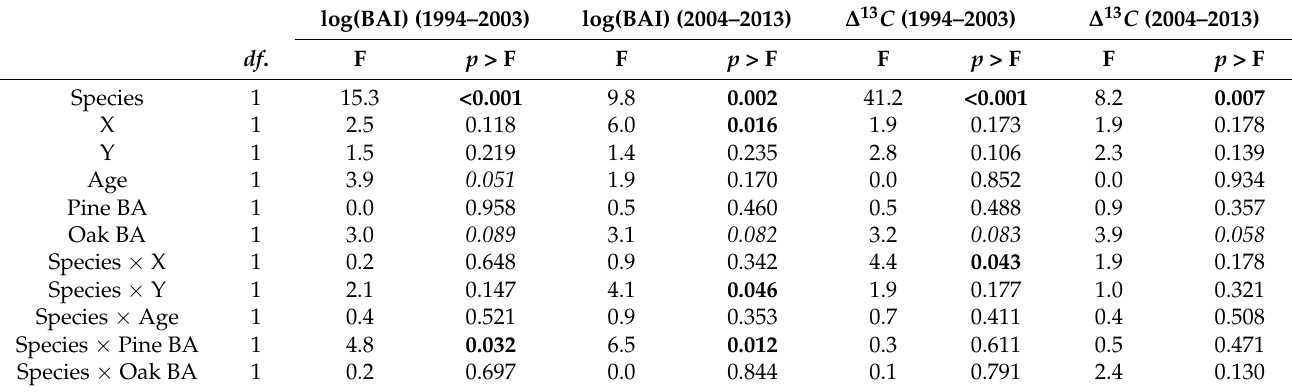
Table A3. Analyses of covariance (ANCOVAs, full models) for log-transformed individual basal area increment (log(BAI)) and carbon isotope discrimination ( ∆ 13 C ) during a wet (1994–2003) and a dry decade (2004–2013). Pine and oak BA, local density of pines and oaks, respectively; X and Y, Easting and Northing coordinates, respectively. Factors with p < 0.05 and p < 0.10 are highlighted in bold and italics,